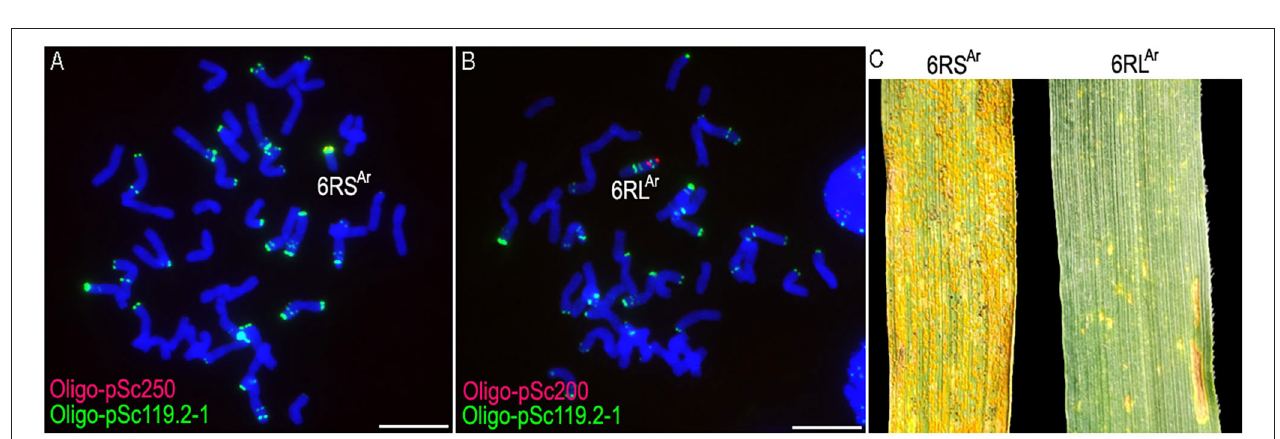
FIGURE 2 | The non-denaturing fluorescence in situ hybridization (ND-FISH) analysis of lines MTA6RS Ar and MTA6RL Ar using probes Oligo-pSc119.2-1 (green), Oligo-pSc200 (red), Oligo-pSc250 (red), and their stripe rust resistance test. (A) A root-tip metaphase cell of line MTA6RS Ar . (B) A root-tip metaphase cell of line MTA6RL Ar . (C) Line MTA6RS Ar was susceptible to stripe rust and line MTA6RL Ar was highly resistant. Scale bar: 10 µ m.